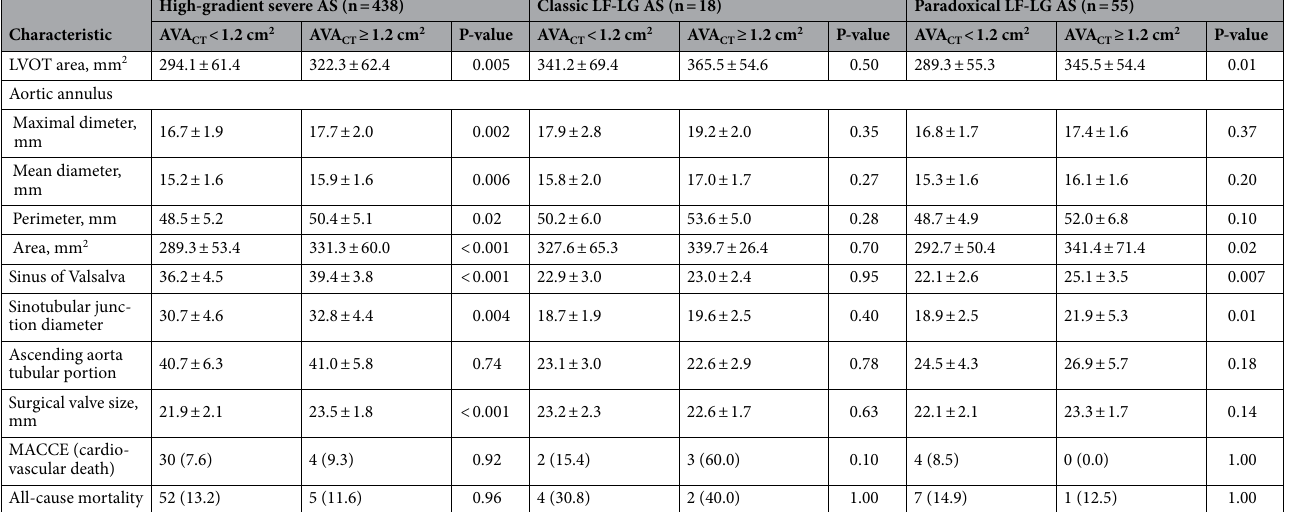
Table 2. Subgroups of LF-LG AS according to AVA CT . AS, aortic stenosis; AVA, aortic valve area; AVA CT , AVA measured on CT; AVC, aortic valve calcium score; BSA, body surface area; CABG, coronary artery